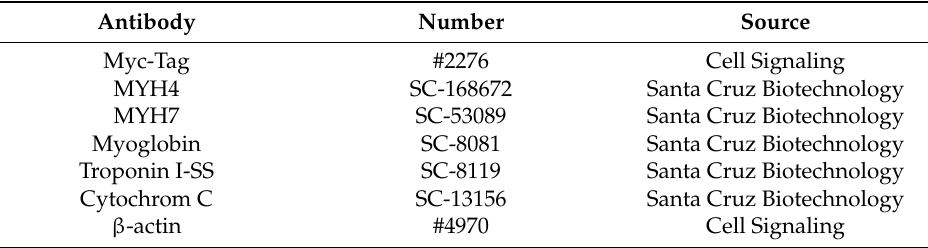
Table 2. List of